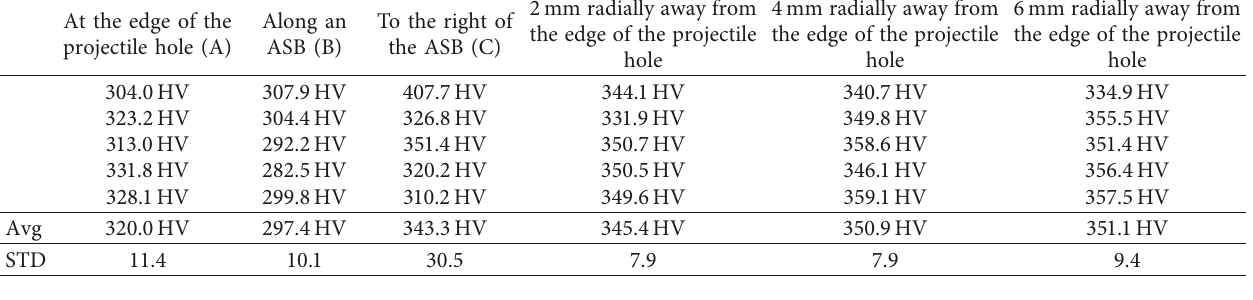
Table 1: Vickers hardness of as-built and stress relieved DMLS Ti6Al4V (ELI), ballistically impacted 10mm thick plate. At the edge of the projectile hole (A)